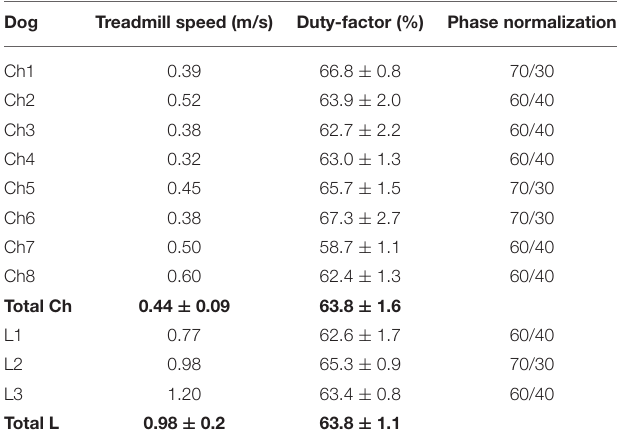
TABLE 2 | Overview of Chihuahuas (Ch) and Labrador retrievers (L) regarding the treadmill speed and duty factor in relation to the left hind limb. Dog Treadmill speed (m/s) Duty-factor (%) Phase normalization